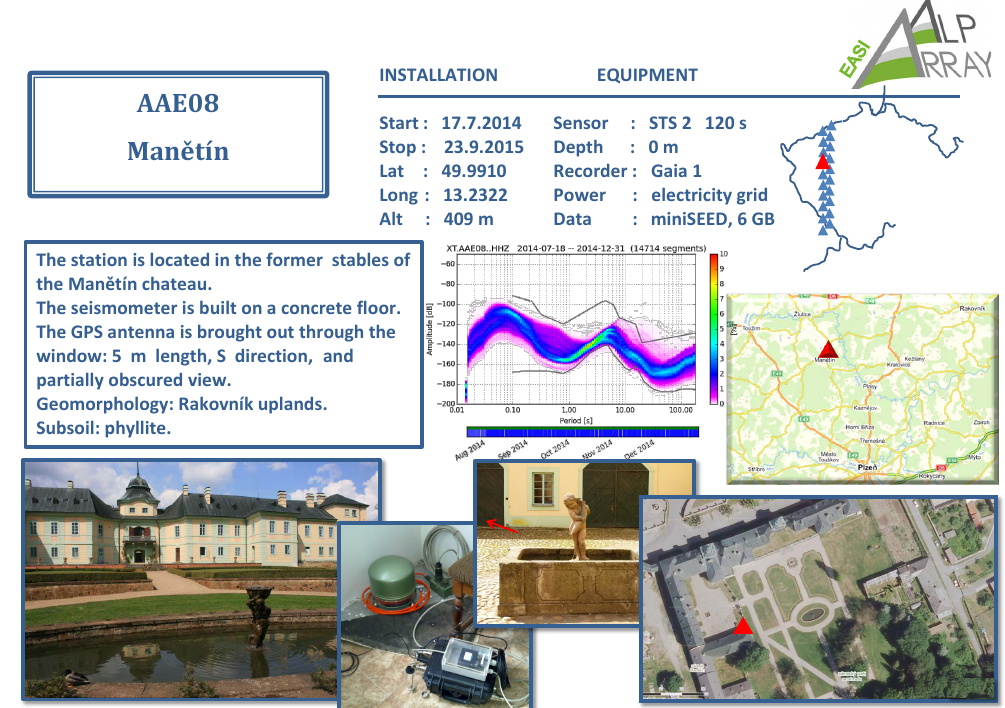
Figure 3. Example of installation of one of the broadband MOBNET stations in the AlpArray-EASI complementary experiment. In addition to the photo-documentation of the installation of the AAE08 station (Manˇetín), we show its location (upper right), station coordinates and period of recordings (top panel), and we describe the installation of accessories (GPS antenna) and the bedrock (left panel in the middle). The central panel shows the probabilistic power spectral density of ambient noise in the vertical component during the first 5 months of the station